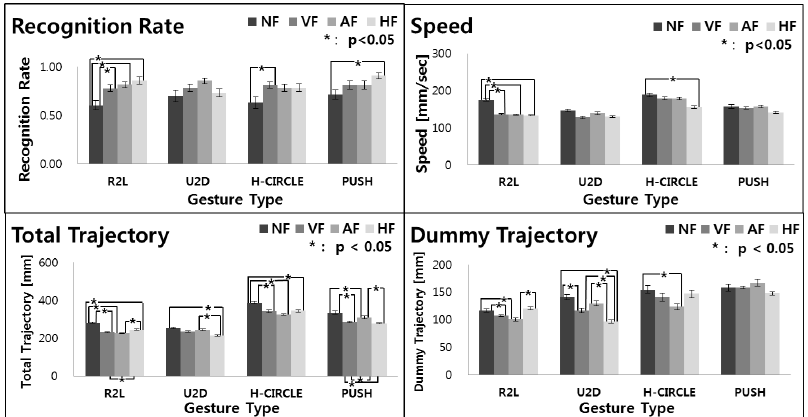
Figure 21. Quantitative evaluation results of the four hand gestures across four feedback